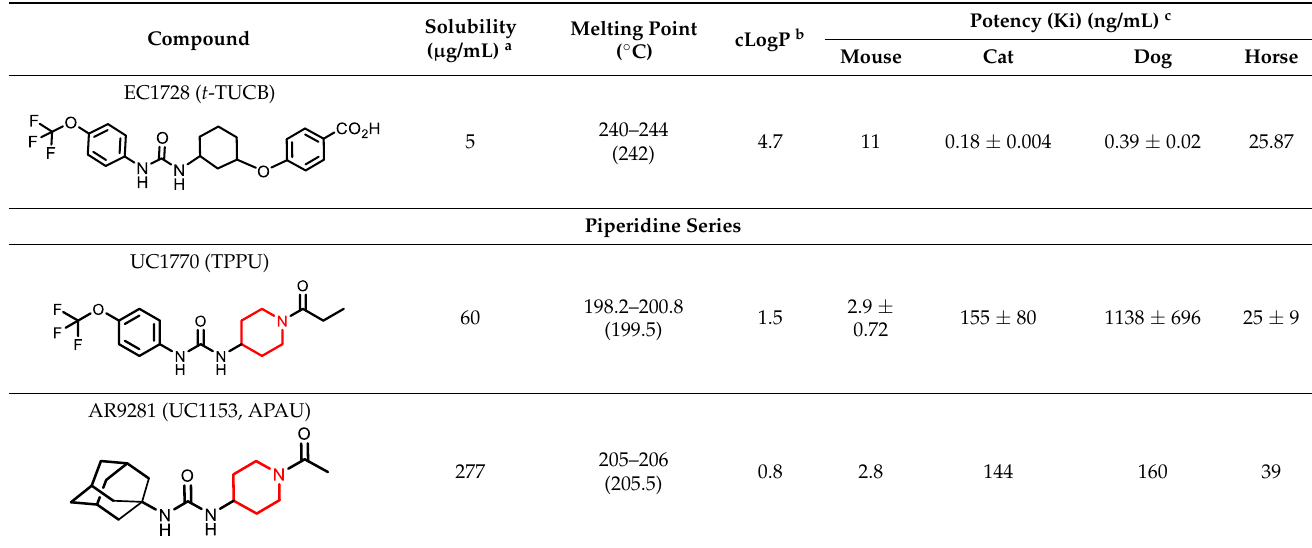
Table 1. Summary of solubility and potency of sEH compounds.